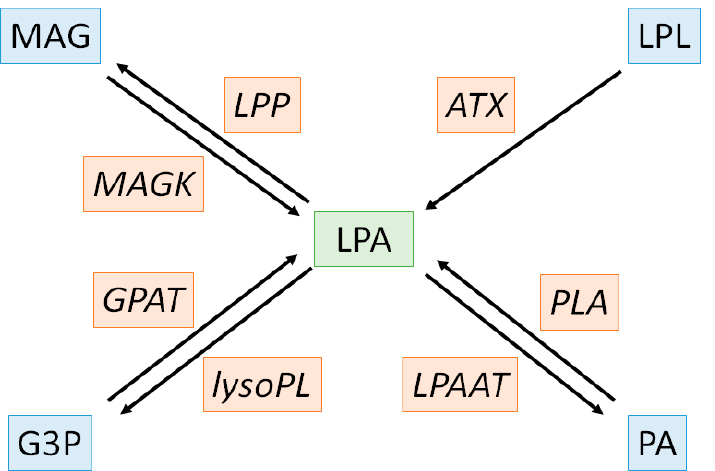
Figure 1. Biochemical pathways of lysophosphatidic acid metabolism. LPA, substrates/products and enzymes are depicted in green, blue and orange, respectively. ATX: autotaxin, G3P: glycero-3- phosphate, GPAT: glycerophosphate acyltransferase, LPA: lysophosphatidic acid LPAAT: lysophos- phatidic acid acyltransferases, LPL: lysophospholipids, LPP: lysophosphatidic acid phosphatase, lysoPL: lysophospholipase, MAG: monoacylglycerol, MAGK: monoacylglycerol kinase, PA: phos- phatidic acid, PLA: